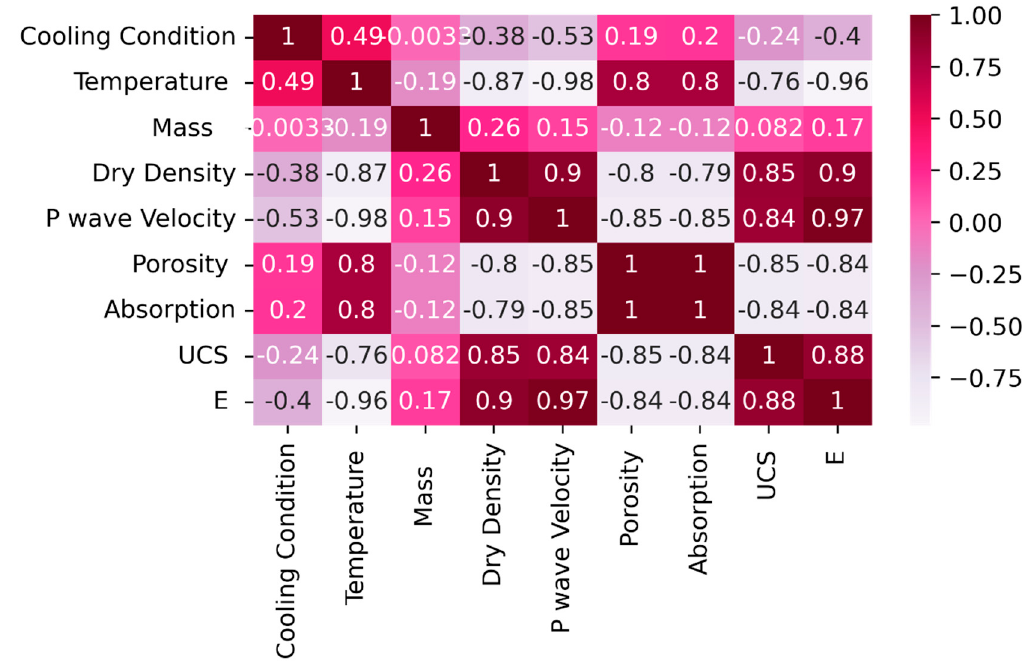
Figure 6. Inputs and outputs correlation matrix.